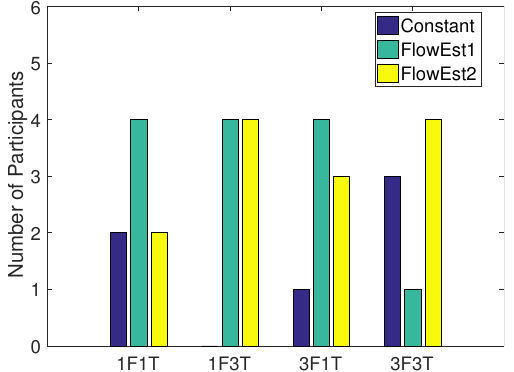
Figure 11. Box plot of the result for ( a ) one finger and ( b ) three fingers.